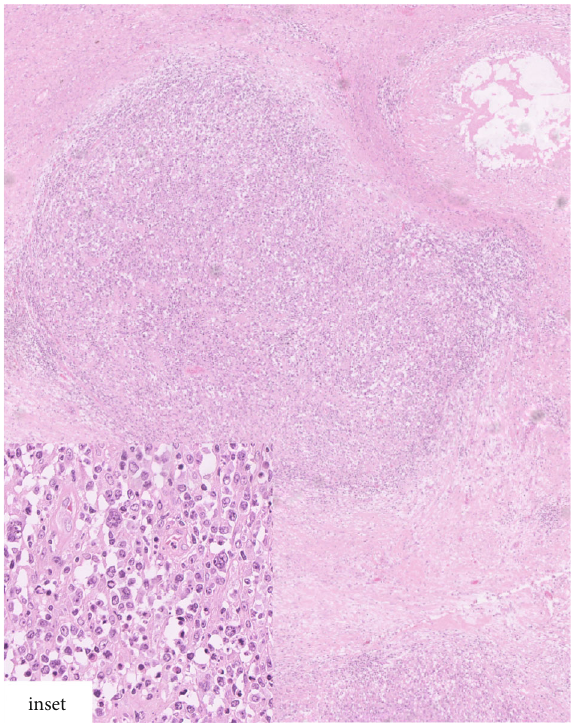
Figure 1: Hematoxylin and eosin staining (H & E 200x). Composite histology of follicular lymphoma within the mature cystic teratoma. The inset shows high-power view of the follicular lymphoma component comprising predominantly centroblasts and scattered centrocytes (H & E